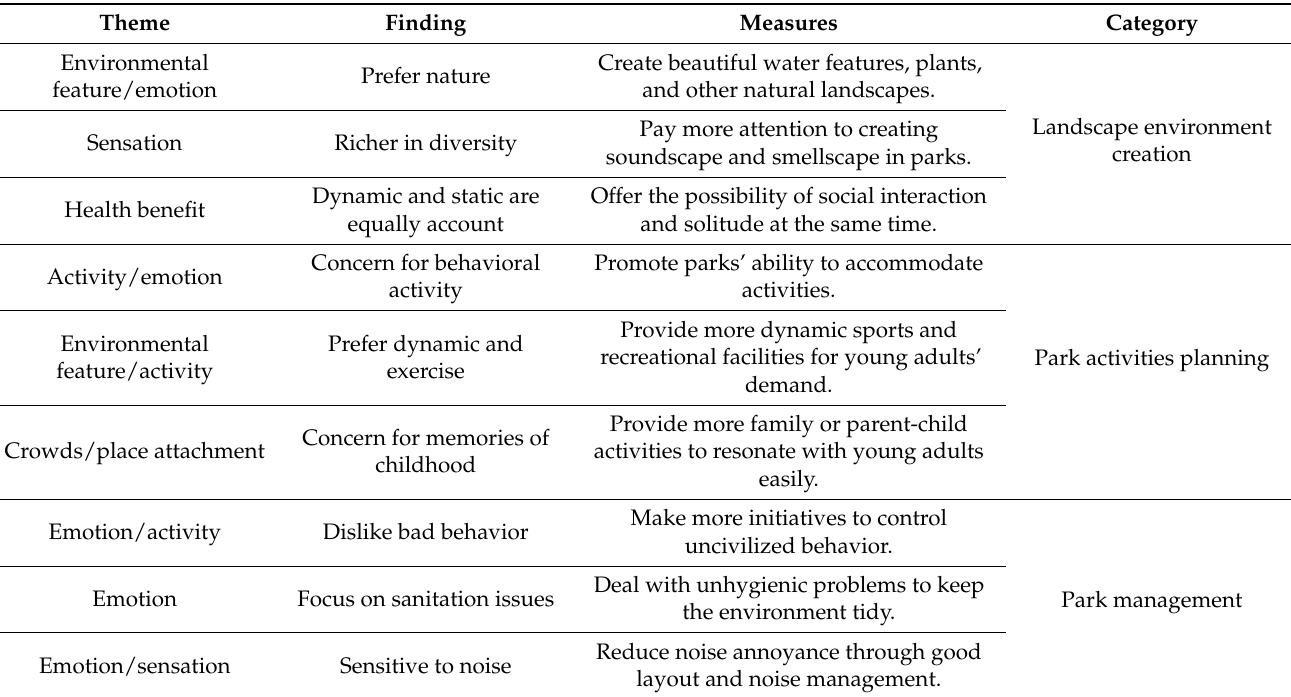
Table 9. Measures to improve the perceived experience of young adults in urban